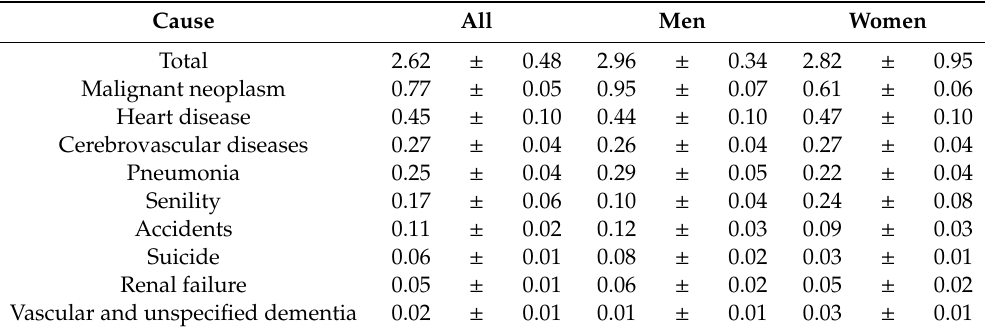
Table 2. Number of deaths stratified by cause in Gifu prefecture,